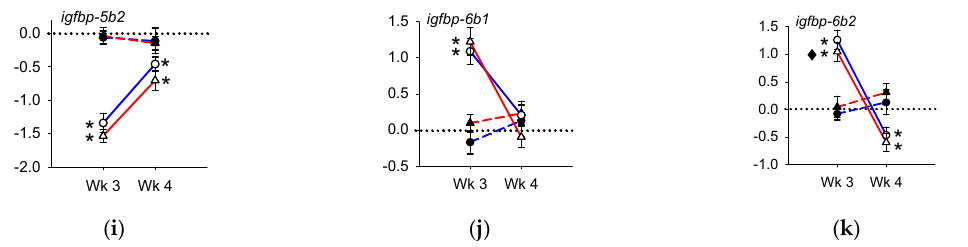
Figure 7. White muscle expression of igfbp genes during fed deprivation (FD) and refeeding in controls (blue lines) and mutants (red lines). Genes are indicated in the top left corner of each panel ( a – k ). The y-axis represents gene expression values normalized to the continuously fed control group from week 3 and expressed as log 2 (fold change). The horizontal dashed line is a visual reference for log 2 (fold change) = 0. Asterisks indicate that the feed deprived (FD, Wk 3) or refed (Wk 4) groups (solid line) differ from continually fed fish (dashed line) within the same treatment group and week ( p < 0.05, n = 21). The black diamond indicates the fold change differs between mutants and controls.